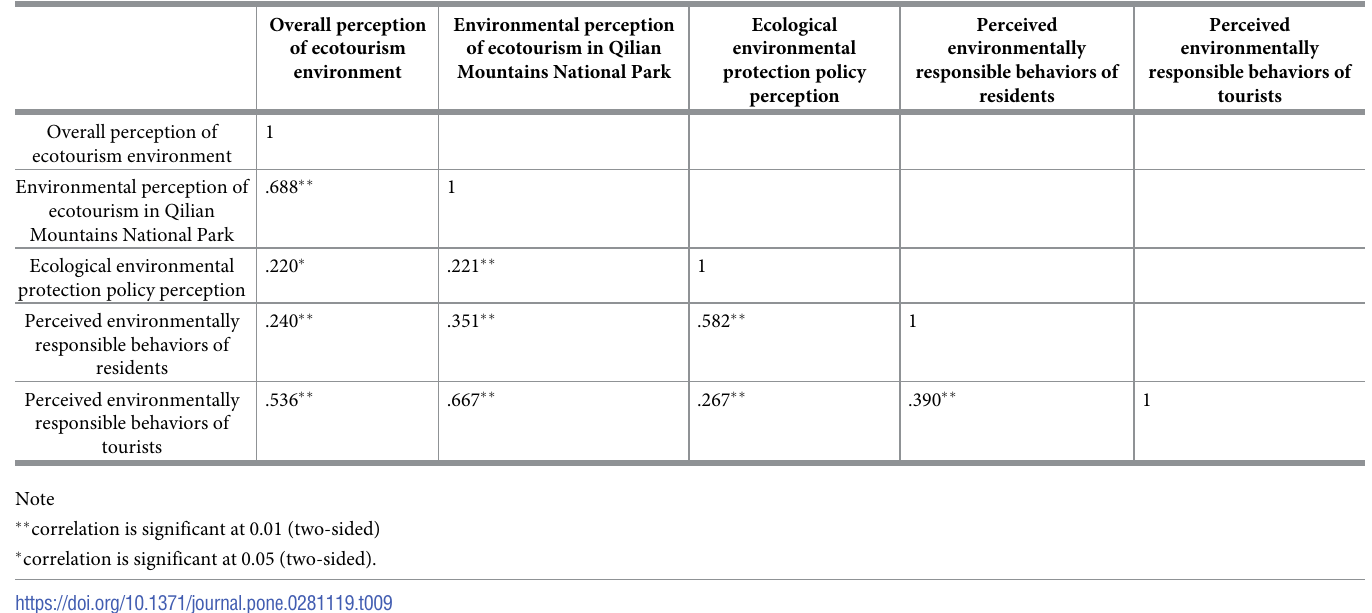
Table 9. Result of correlation analysis in residents’